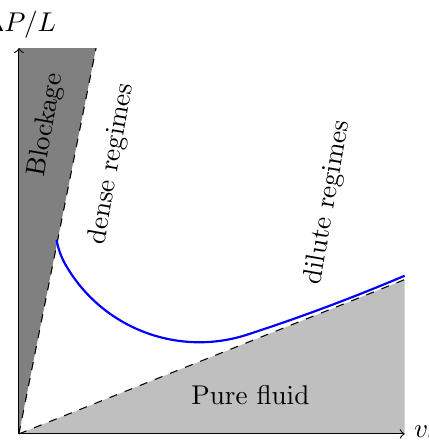
Figure 5. Schematical pressure drop ∆ P / L vs carrying fluid ve- locity v G diagram used to represent specific curves (solid line). Limits due to pure fluid transport and obstruction are represented by the grayed and dark grayed areas.